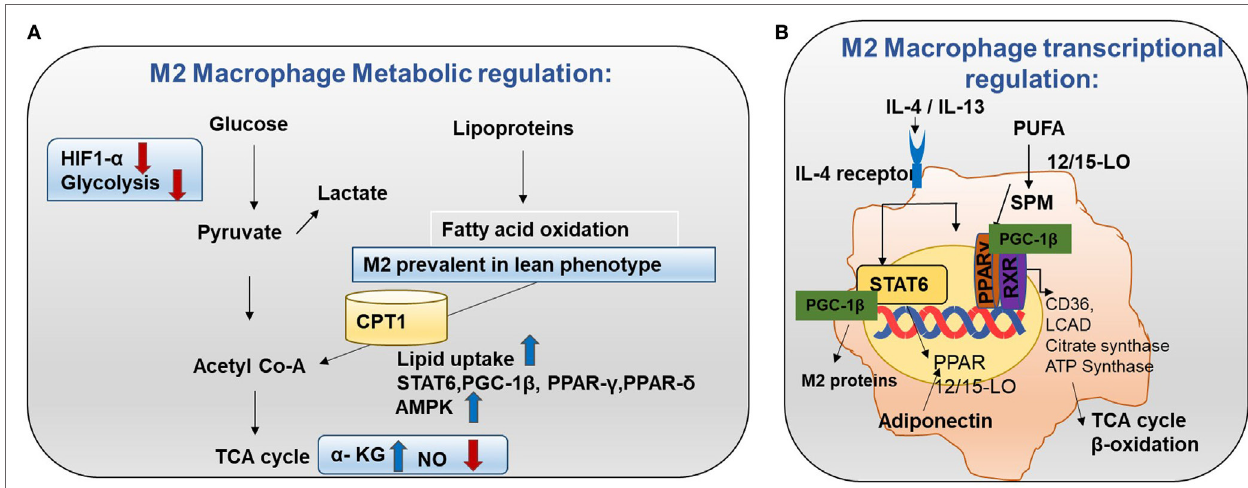
FiguRe 4 | Metabolism in M2 macrophages. (A) M2 macrophage metabolic regulation: M2 macrophages adopt a metabolic program fueled by fatty acids and oxidative phosphorylation (OXPHOS). M2 macrophages are seen in lean adipose tissue and lipid uptake is increased in M2 macrophages (8). Both OXPHOS and FAO are important for the anti-inflammatory function of M2 macrophages. In M2 macrophages, glycolysis is impaired due to low HIF-1 α activity and low expression of the active 6-phosphofructo-2-kinase/fructose-2,6-biphosphatase 1 (PFKFB1). Also, high α -KG/succinate ratio promotes the M2 phenotype. This could be due to the high flow of the TCA cycle or glutamine metabolism. M2 macrophages will channel FA toward re-esterification and β -oxidation. β -oxidation is channeled through carinitine palmitoyl transferase 1 (CPT1) (9). The high rates of OXPHOS in M2 macrophages are caused by low nitric oxide (NO) production and high adenosine monophosphate-activated protein kinase (AMPK) activity. (B) M2 macrophage transcriptional regulation: omega-3 polyunsaturated fatty acids (PUFA) undergo enzymatic transformation by 12/15-LO (lipoxygenase) and other enzymes in the production of specialized pro-resolving lipid mediators (SPMs) and intermediate metabolites that are potent PPAR ligands. M2-inducing cytokines IL-4 and IL-13 promote STAT6 phosphorylation to induce transcription of PPARs ( γ and δ ) and their coactivator PPAR γ -coactivator-1 β (PGC-1 β ). M2 exhibit enhanced PPAR- γ activity. PPAR- γ forms a heterodimer with RXR to induce OXHOS regulating proteins. PGC-1 β promotes the STAT6 transcription complex and expression of M2 proteins such as arginase-1 and the pattern-recognition/endocytic receptor CD206. The STAT6 transcription complex further increases transcription of TCA cycle enzymes such as citrate synthase, CD36 (fatty acid transporter), ATP synthase, 12/15 lipoxygenase (converts omega-3 PUFA to SPMs), and LCAD (long chain acyl dehydrogenase, an enzyme for β -oxidation). Adiponectin activates PPARs in M2 macrophages and consequently increases β